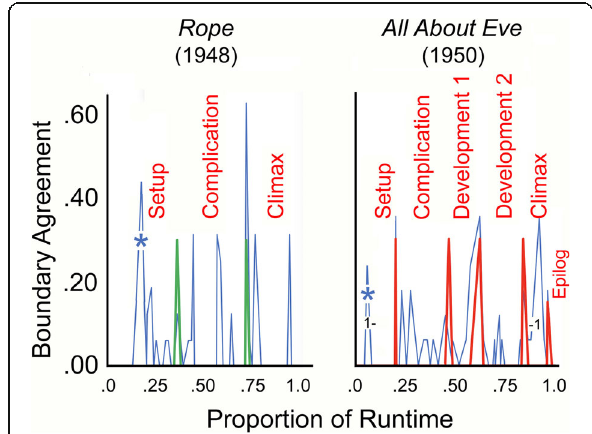
Fig. 2 The correspondence between viewer segmentations (agreements that a narrative boundary had occurred; thin blue spikes ) and those that that follow the rubrics of Thompson (1999) and Bordwell (2006) as thicker green spikes , and those provided by Bordwell (personal communication) as thicker red spikes . The numbers in the right panel denote the time period of the flashback